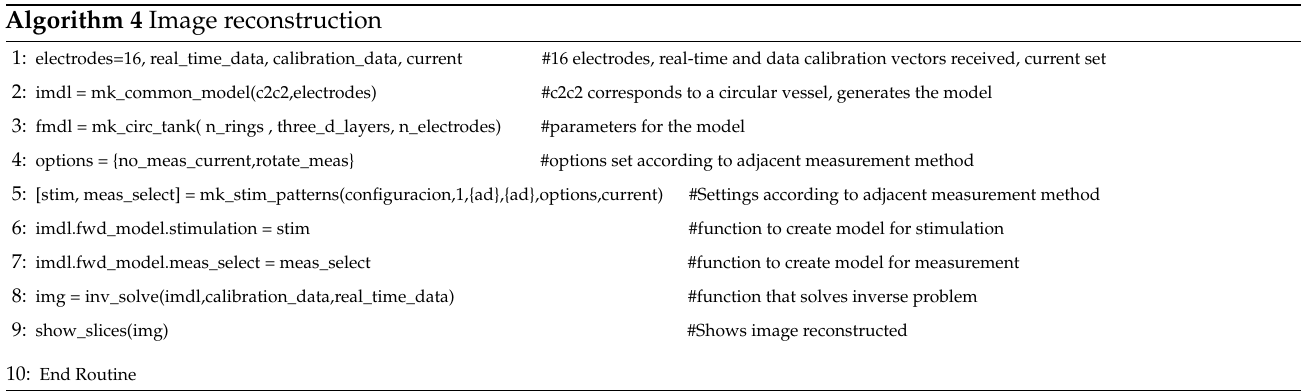
Algorithm 4 Image